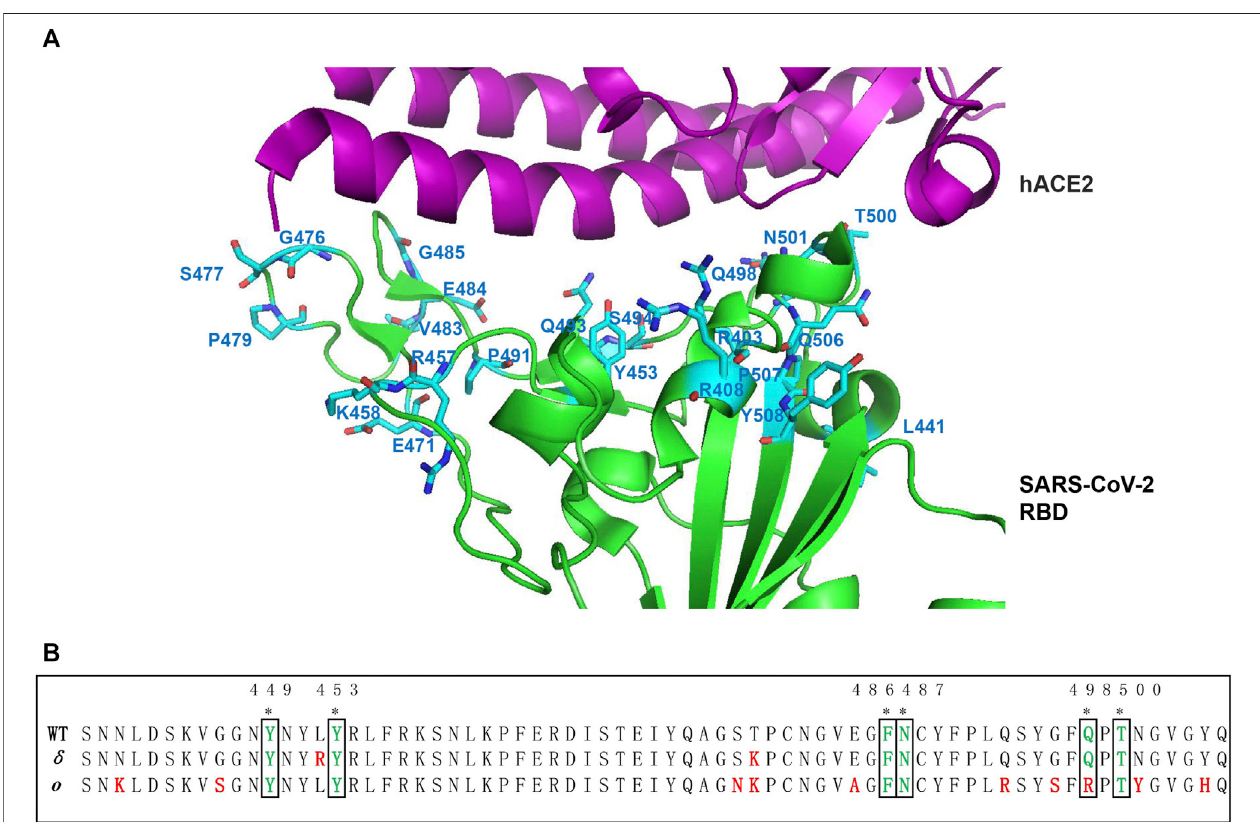
FIGURE 3 | Mutation hotspot of SARS-CoV-2 RBM. (A) Compared with SARS-CoV-2 from Wuhan-HuBei-1, the mutation hotspot on ACE2 interaction sites of SARS-CoV-2 RBM is mapped on to the crystal structure of RBD complex with ACE2 side-chain residues (PDB code: 6LZG) (Wang Q. et al., 2020). The 22 suggested ACE2 interaction mutation residues including R403, R408, L441, Y453, R457, K458, E471, G476, S477 , P479, V483 , E484, G485, P491, Q493, S494, Q498, T500, N501 , Q506, P507, and Y508 are shown in blue (Guruprasad 2021b). Among which, S477N, V483A, and N501Y are more frequent mutations. (B) Sequence alignment of ACE2 interaction residues on RBM between WT, Delta, and Omicron variant. The 6 common ACE2 interaction sites were indicated by asterisk on the top. The mutation residues in the RBM of Delta and Omicron variants were indicated by red color.